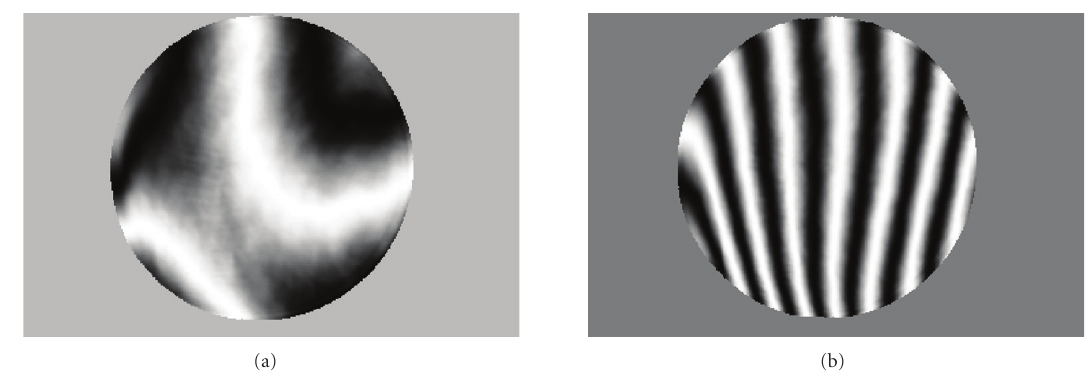
Figure 3: OPD Maps for (a) an aligned state and (b) for ε x equal to 25 μ m.